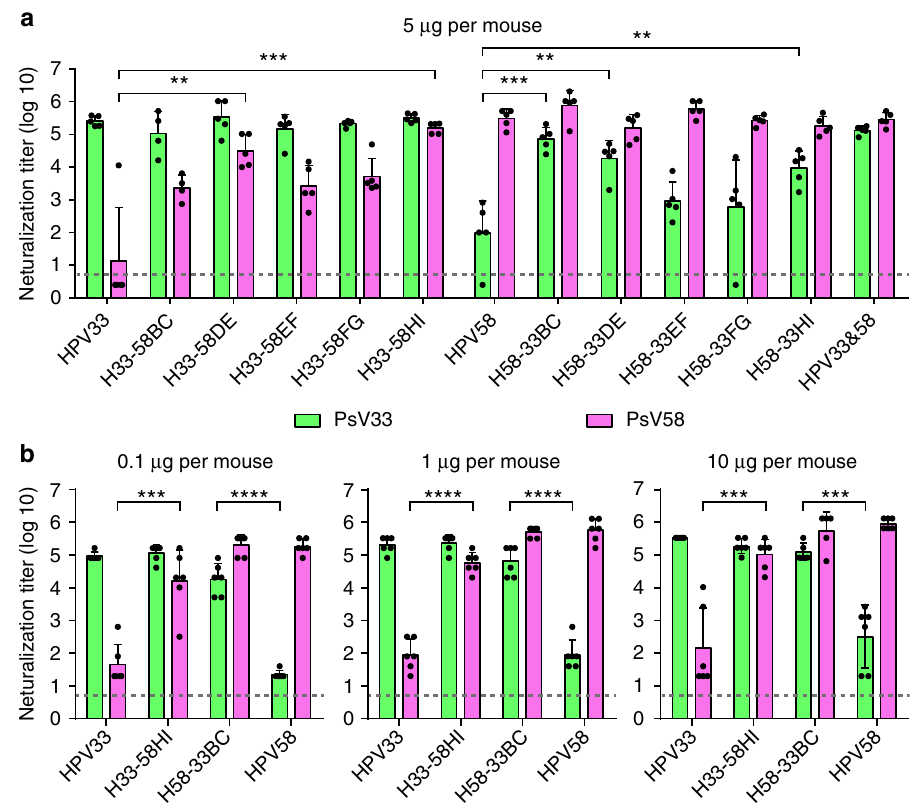
Fig. 3 Immunogenicity of loop-swapped HPV33/58 chimeric VLPs. a Neutralization titers of immune sera from BALB/c mice ( n = 5) collected four weeks after the third immunization (immunization at weeks 0, 2 and 4 with 5 μ g per dose of aluminum adjuvant-containing chimeric or WT VLPs). A group of mice immunized with mixed WT HPV33 and HPV58 VLPs was labeled. (*) denotes signi fi cant differences as compared with the neutralization titer induced by the corresponding backbone type. b Groups of mice ( n = 6) were immunized with 0.1, 1 or 10 μ g per dose of the selected chimeric or WT HPV33/58 VLPs at weeks 0, 2 and 4. Immune sera were collected at week 8 and analyzed by neutralization assays. All the data were analyzed by one-way analysis of variance (ANOVA), ** P < 0.01; *** P < 0.001; **** P < 0.0001. The error bars are standard deviation and symbols represent individual mice. The dotted line indicates the limit of detection for the assay. Non-neutralizing sera were assigned a value of one-half of the limit of detection for to assess their cross-type immunogenicity. Of the eight triple-type chimeric VLPs, H33-58HI-52DE and H33-58HI-52FG showed the highest anti-HPV52 antibody titers (4700 – 2200 and Table 2 Half-effective dosage (ED 50 ) of double-type and